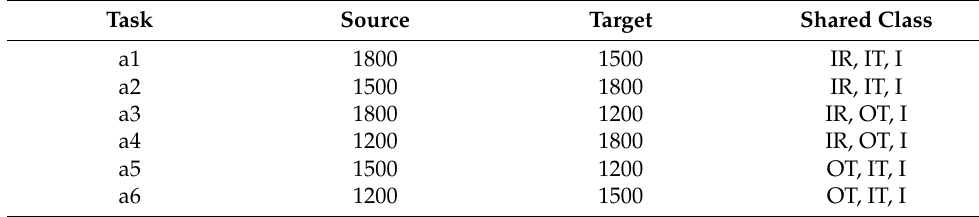
Table 2. The transfer task settings in the lab gearbox